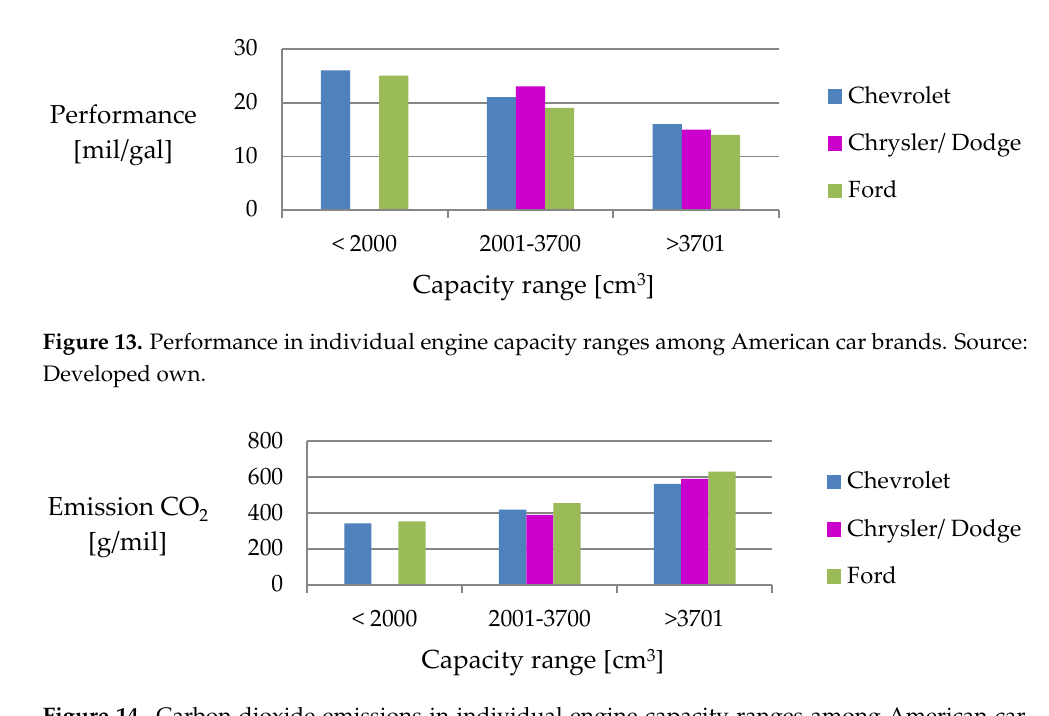
brands. Source: Developed own. Figure 14. Carbon dioxide emissions in individual engine capacity ranges among American car